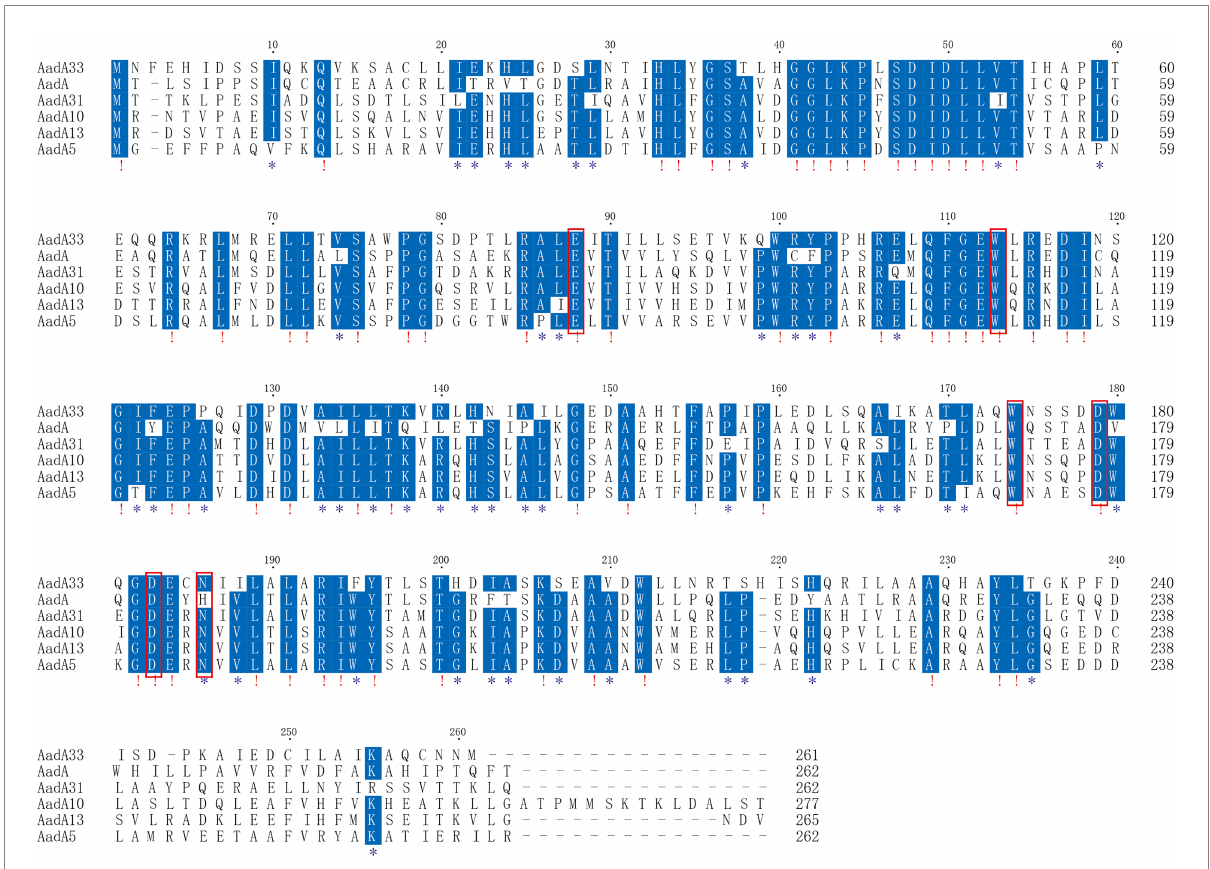
FIGURE 4 Multiple sequence alignment of AadA33 with other close relatives. Exclamations indicate fully conserved residues; asterisks indicate strongly similar residues; gaps are represented using hyphens. The numbers on the right represent the corresponding sequence length. The red frames indicate functional residues. Accession numbers of AadA proteins: AadA (Q8ZPX9), AadA31 (AUX81654.1), AadA10 (AAL36430.1), AadA13 (ABW91178.1) and AadA5 (AAF17880.1).